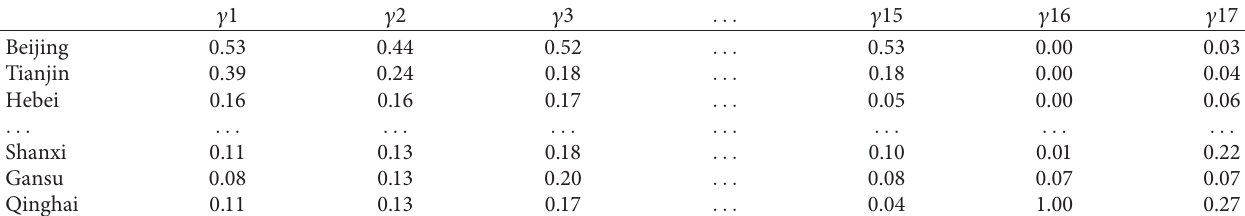
Table 4: Normalized matrix for the green finance development index in 2004.